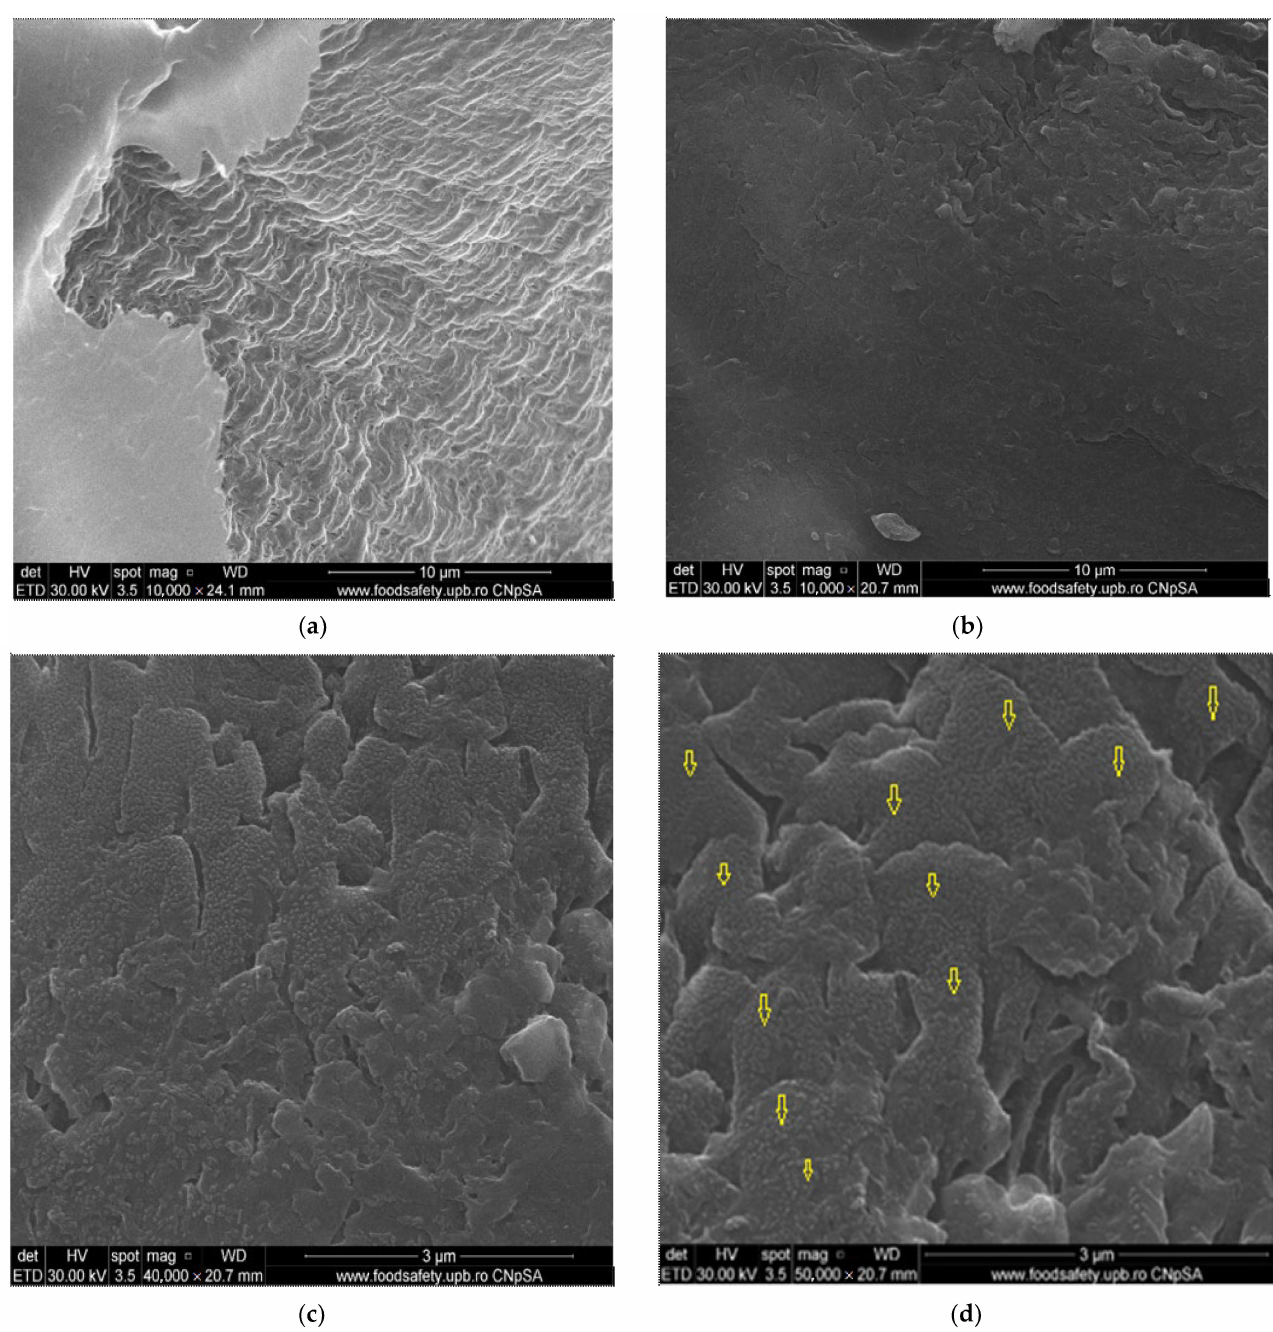
Figure 5. Top surface scanning electron microscopy (SEM) images for the Chi/sEPDM/PPy composite membranes: ( a ) 10,000 × ; ( b ) 10,000 × ; ( c ) 40,000 × ; and ( d ) 50,000 ×